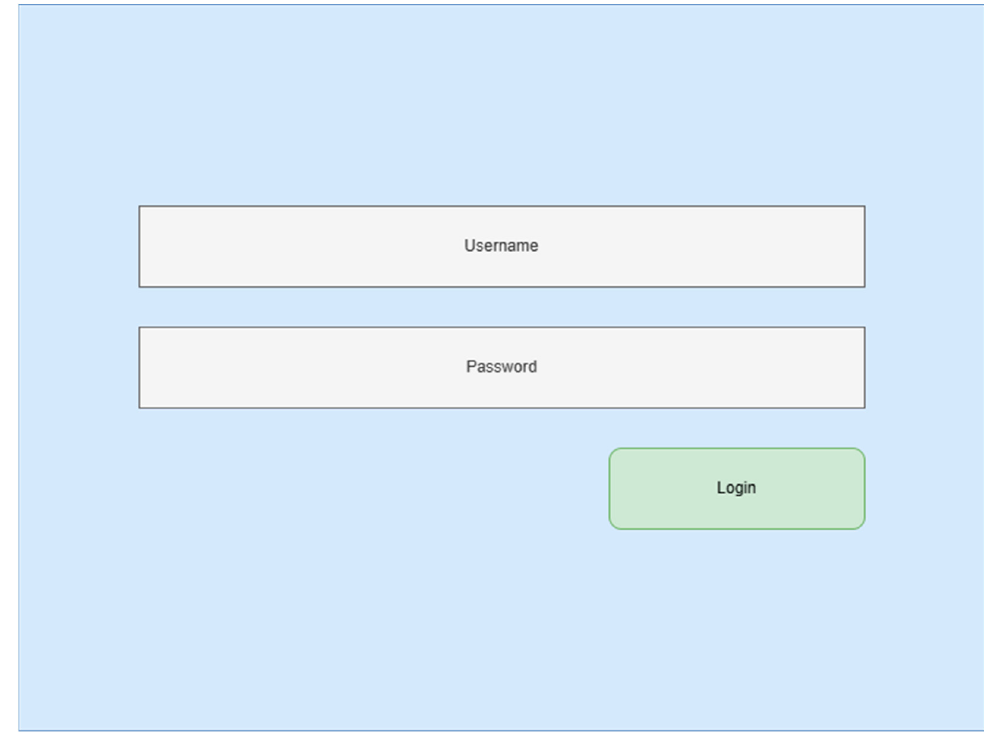
Figure 11. Login page